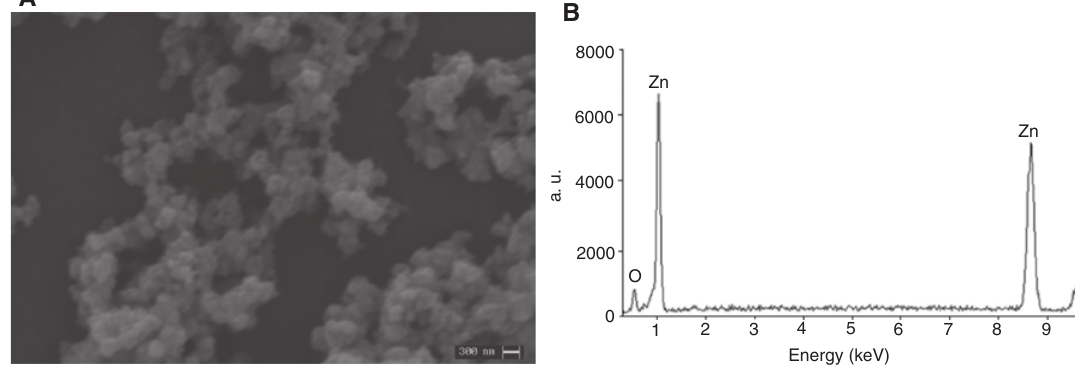
Figure 4: SEM image and EDS spectrum of the ZnO nanoparticles.